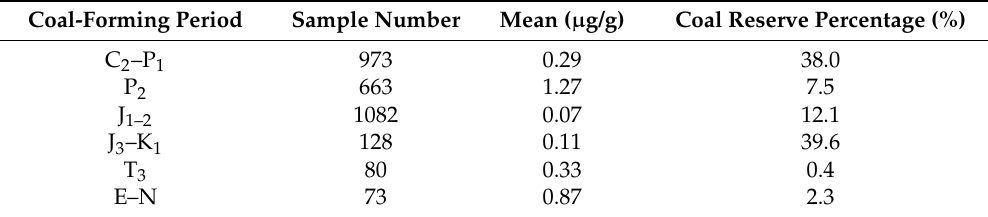
Table 7. The arithmetic average of cadmium in different coal-forming